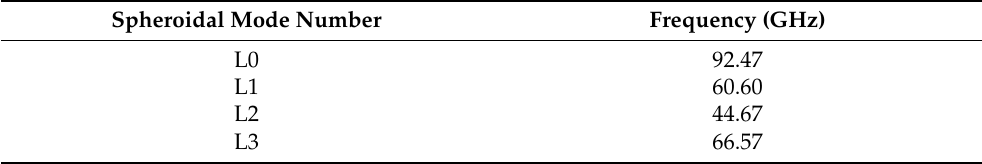
Table A1. Frequencies of the first few modes of a sphere, with longitudinal wave speed 1800 m/s and Poisson’s ratio